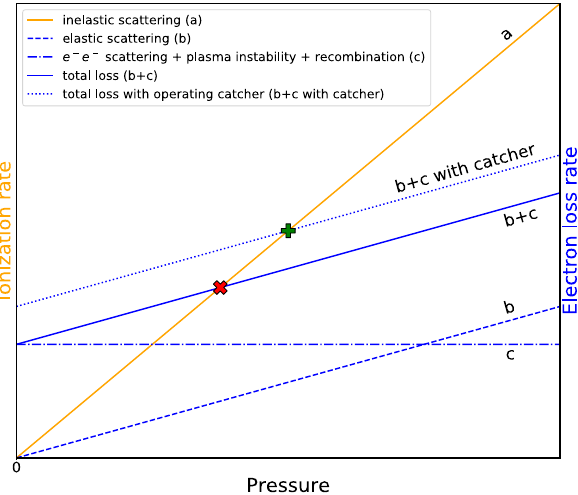
Fig. 3 A schematic qualitative illustration of the ionization rate due to electron inelastic scattering (solid orange line) and the electron-loss rate (solid blue line). The latter rate has contributions from elastic scat- tering (dashed blue line) and Coulomb interaction together with recom- bination (dash-dotted blue line). In the pressure region to the left from the crossing point of these two processes (red cross) the electron-loss rate dominates, preventing the Penning trap from igniting. A contin- uous operation or a periodic movement of an electron catcher would increase the total electron-loss rate, thereby shifting the corresponding line upwards (dotted blue line) and shifting the crossing point to higher pressures (green